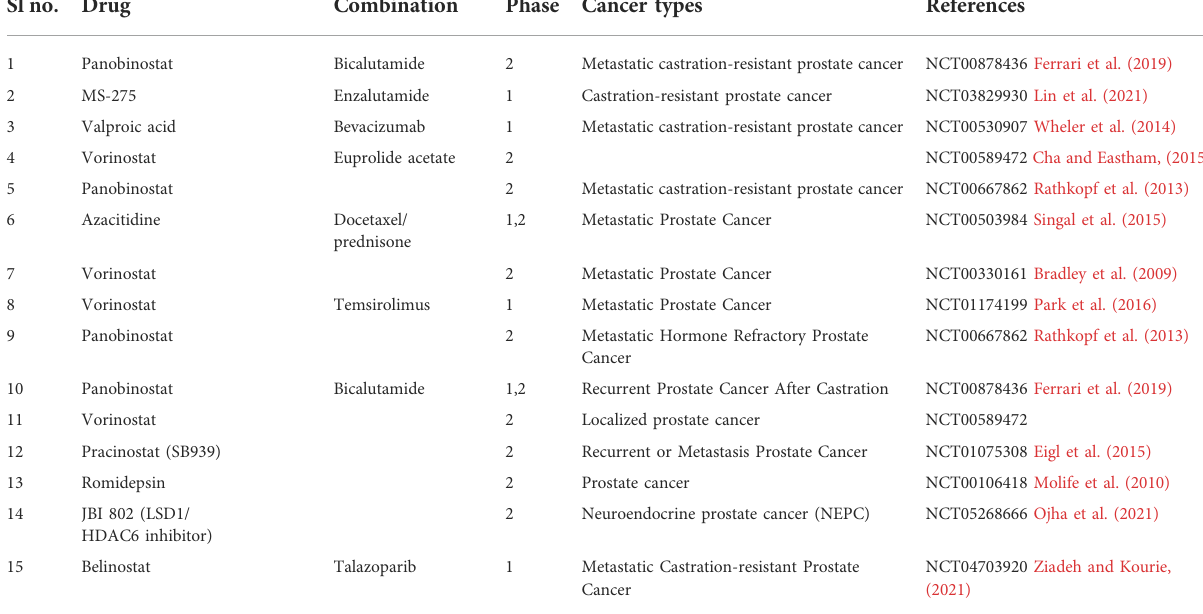
TABLE 4 HDACi in a clinical trial for the treatment of prostate cancer. Sl no.